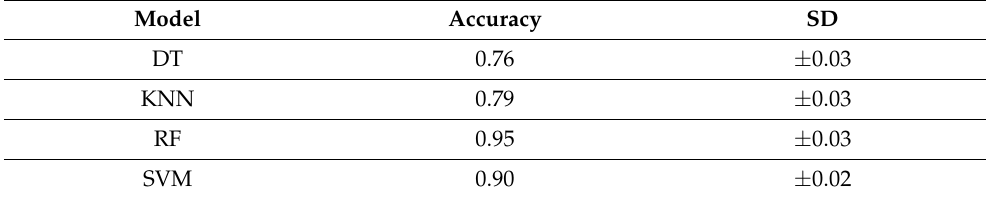
Table 13. Ten-fold cross-validation results of machine learning models using the proposed approach. Model